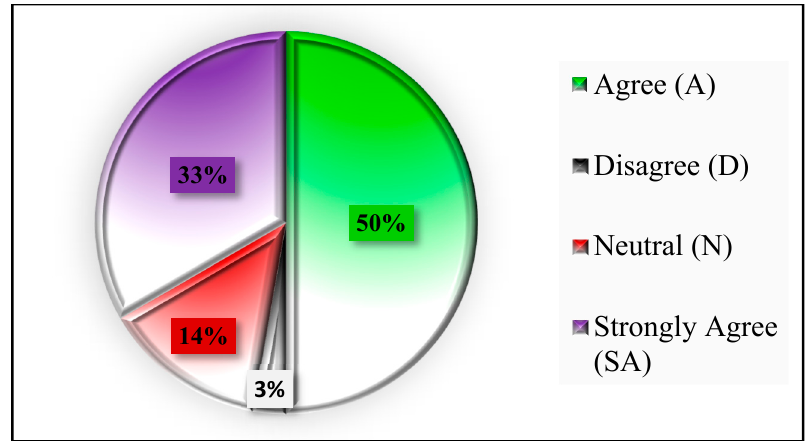
Figure 6. Risk analysis and mitigation in project management .